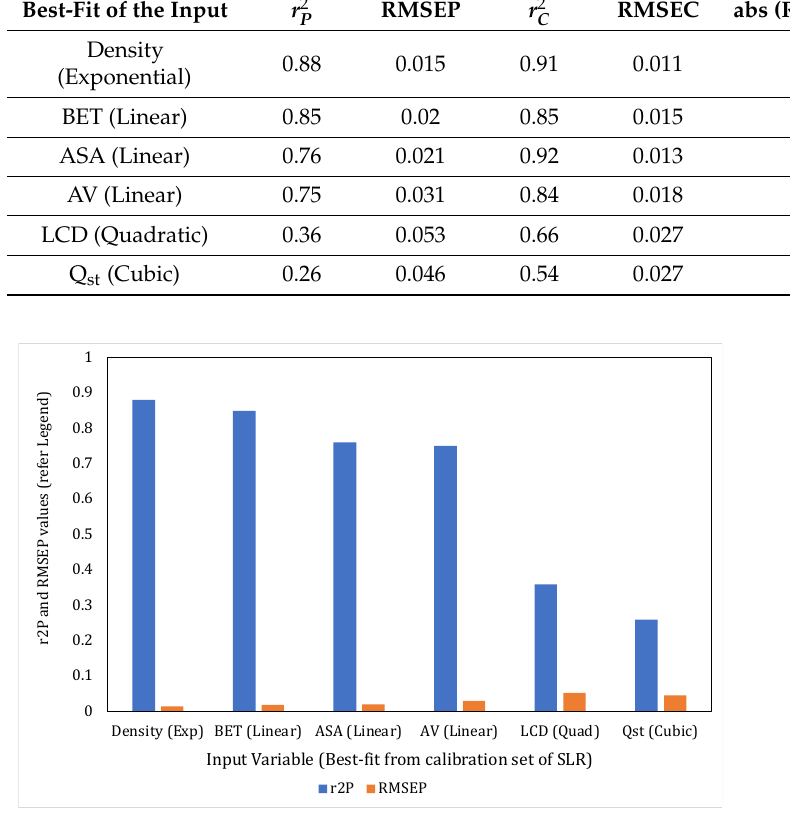
Figure 4. Comparison of r 2 and RMSEP values for the different best-fit transformations of the input variables of the SLR models from the calibration set tested on the validation set.